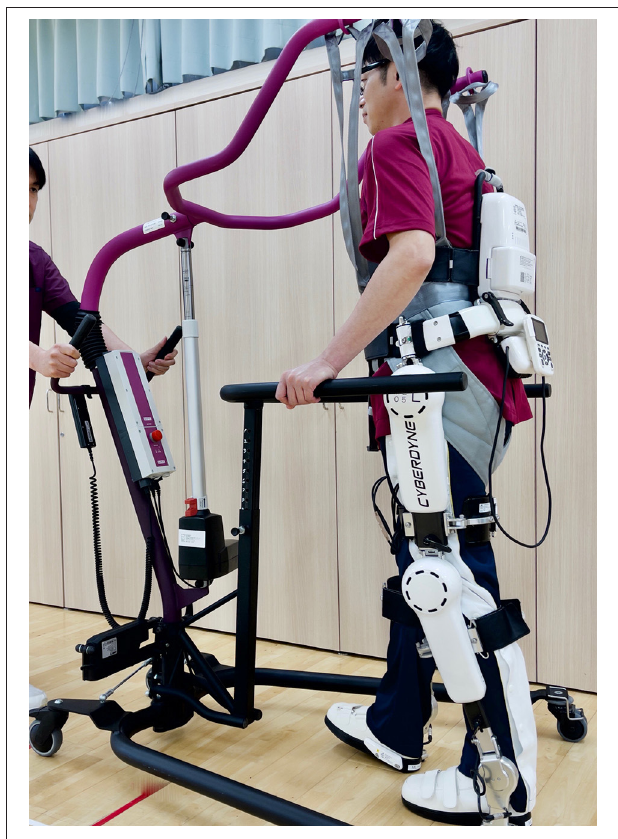
FIGURE 1 | A photograph showing a hybrid-assisted limb (HAL) for medical use (lower limb type) ( 20). For safety reasons, we also used a mobile hoist (All-in-One ® , Ropox A/S, Denmark) to prevent falls during cybernic treatment with